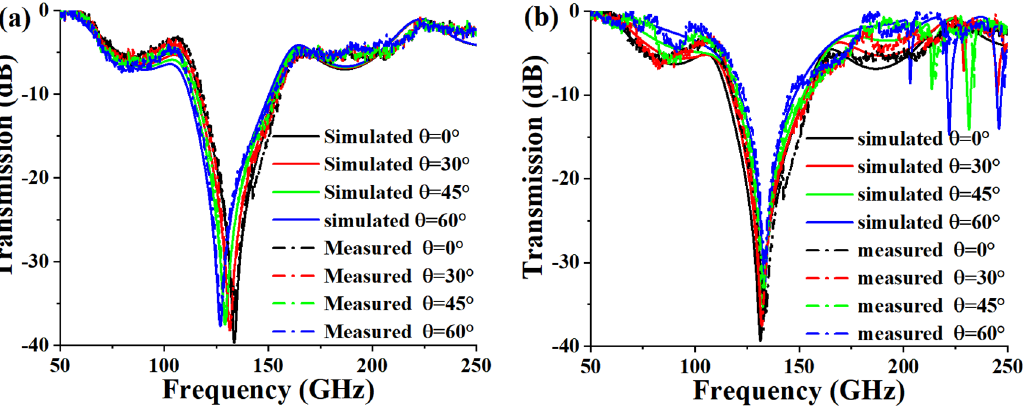
Figure 9. Comparison of measured and simulated results for different incident angle. ( a ) TE mode. ( b ) TM